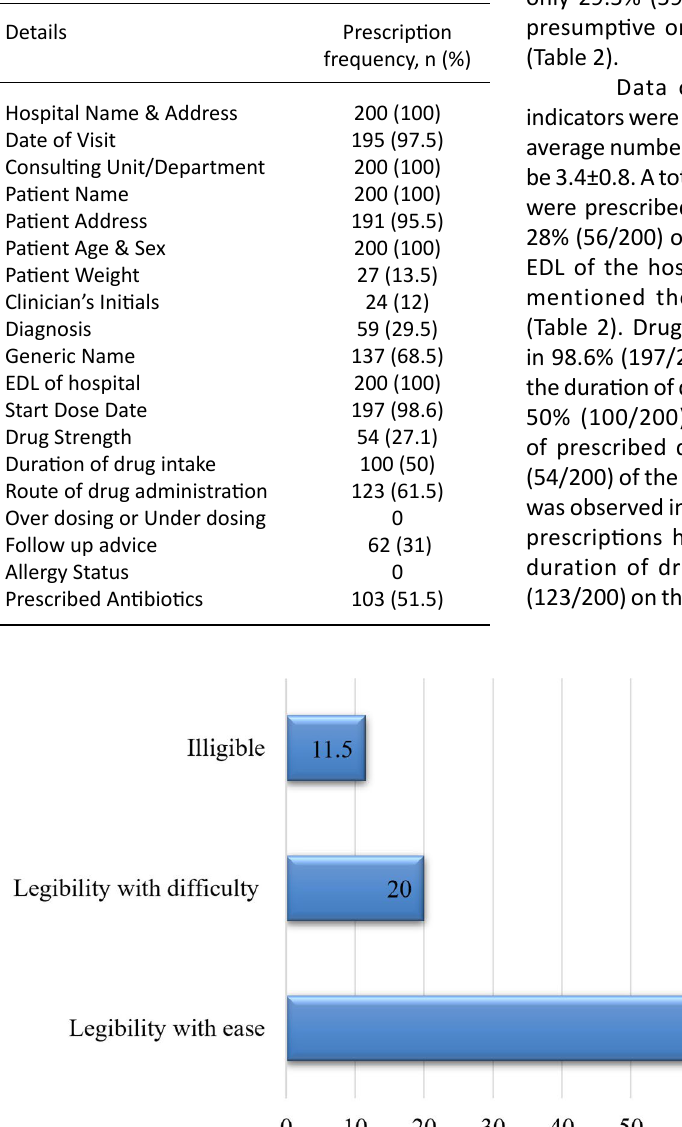
Table 2. Evaluation of various prescription parameters